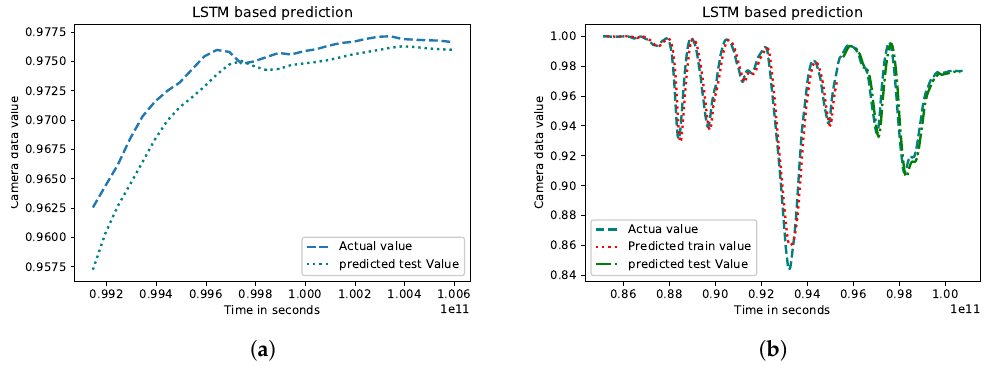
Figure 7. LSTM prediction output for the ( a ) 30 data points and ( b ) all data points from the data